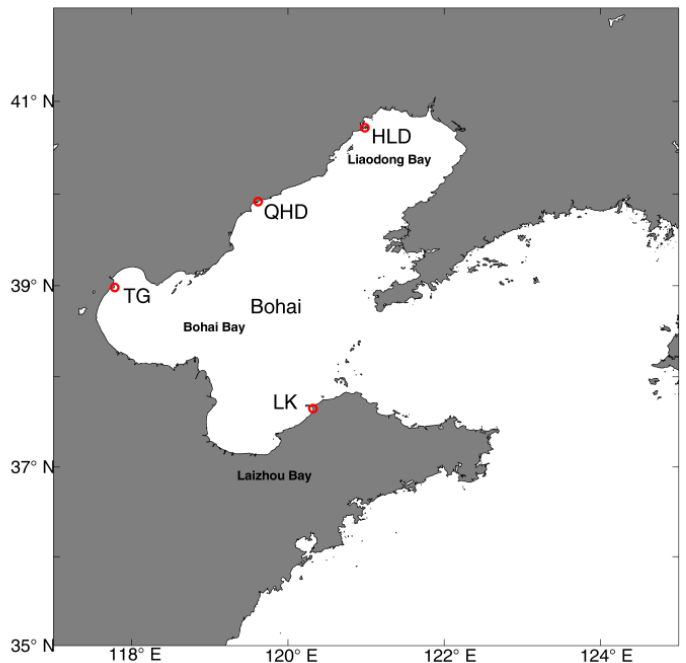
Figure 1. Four tide gauges, Huludao (HLD), Qinhuangdao (QHD), Tanggu (TG) and Longkou (LK), along the coast of the Bohai Sea; and three bays in the Bohai Sea, Liaodong Bay, Bohai Bay and Laizhoy Bay.